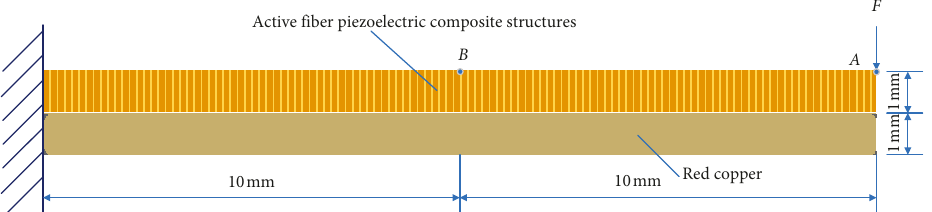
Figure 14: Geometry of the bilayered PCMs